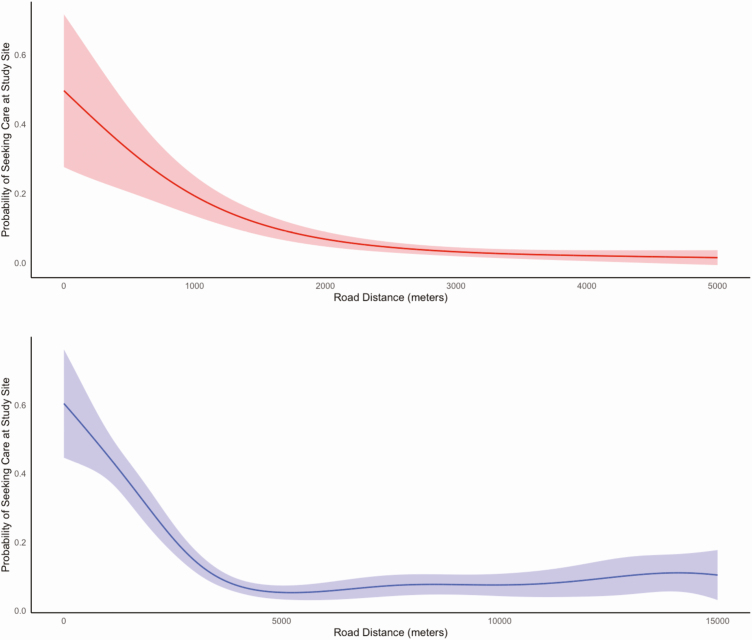
Probability of seeking care at study site as a function of road distance between household and the study site for Kathmandu (top) and Kavrepalanchok (bottom).